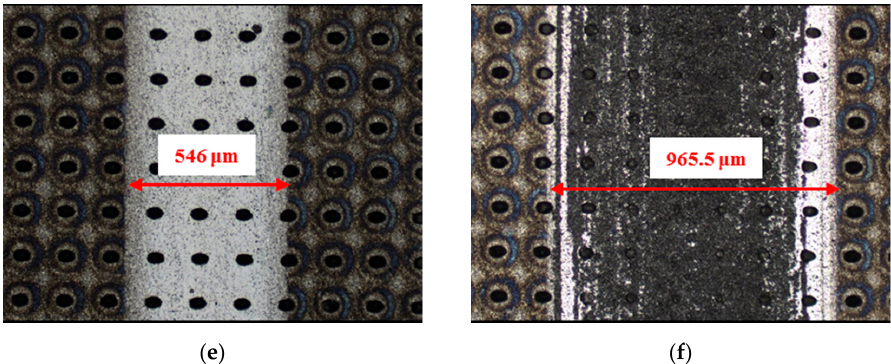
Figure 8. Wear performance of circular-dimple-textured SiC under dry-friction conditions with a load of 30 N (×10): ( a ) 3 μ m circular-dimple-textured SiC-steel ball, ( b ) 3 μ m circular-dimple-textured SiC–Si 3 N 4 ball, ( c ) 5 μ m circular-dimple-textured SiC–steel ball, ( d ) 5 μ m circular-dimple-textured SiC–Si 3 N 4 ball, ( e ) 10 μ m circular-dimple-textured SiC–steel ball, and ( f ) 10 μ m circular-dimple-textured SiC–Si 3 N 4 ball.